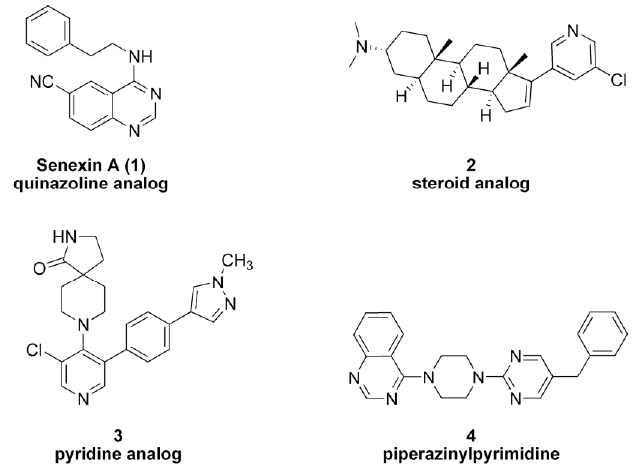
Figure 1. CDK8 inhibitor structures of diverse chemotypes.